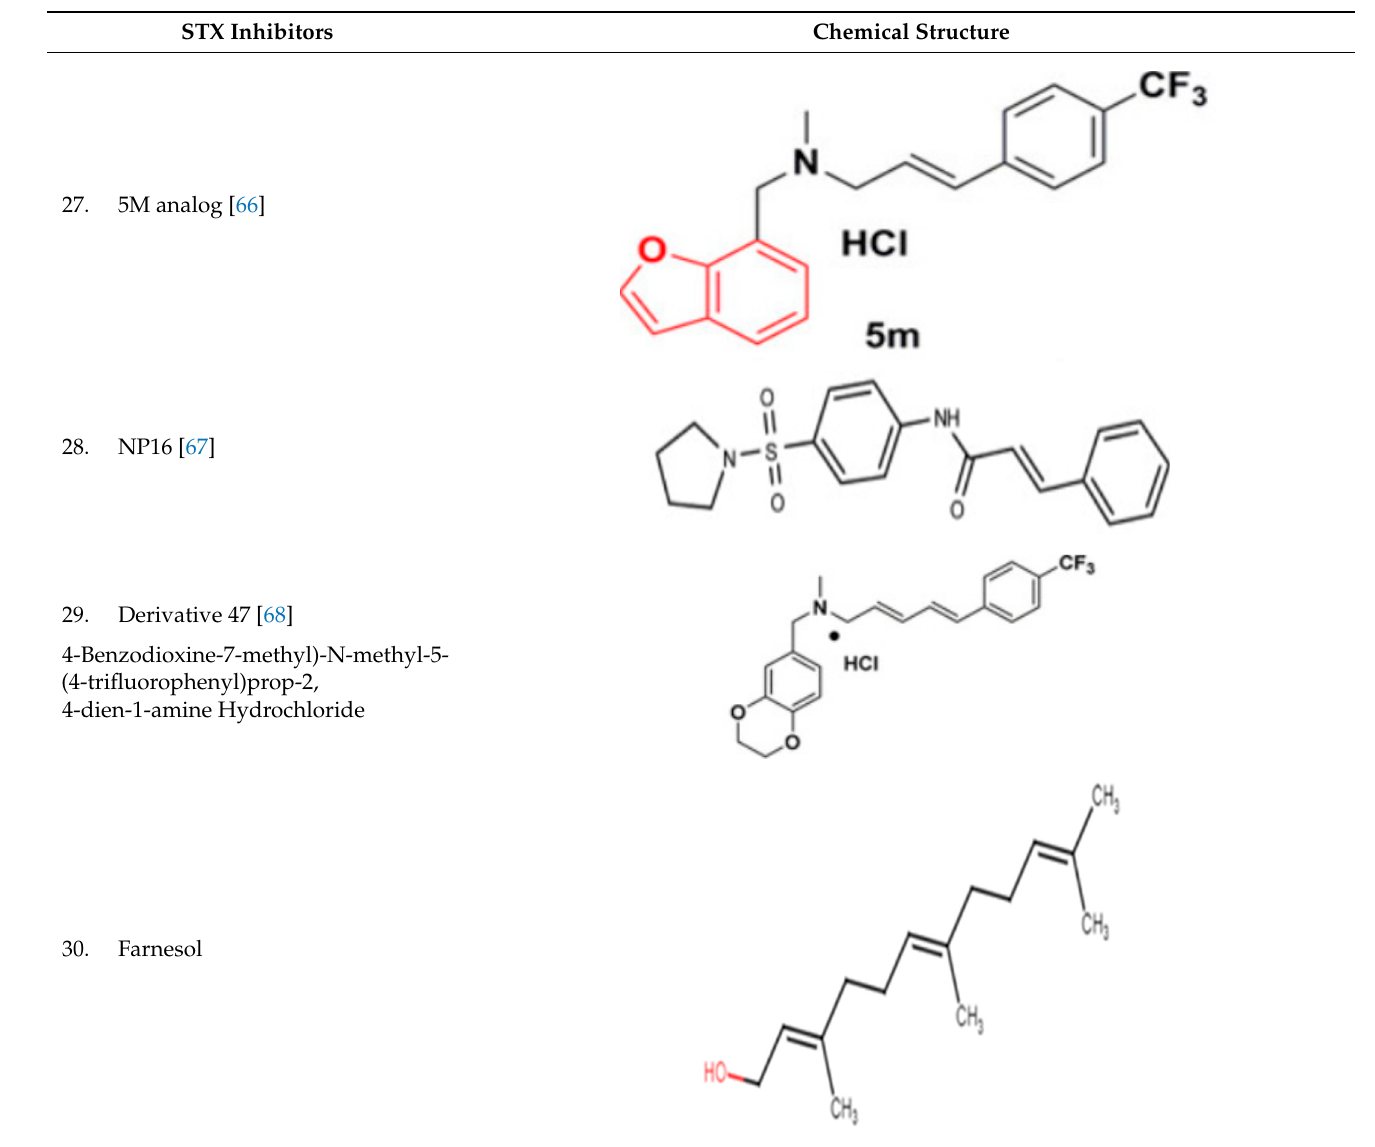
Table 2. Structure activity relationship (SAR) of previously studied STX inhibitors. Compound Structure Activity Relationship (SAR) Carbonyl moiety is crucial for activity, interacts with adjacent amino acid Flavone